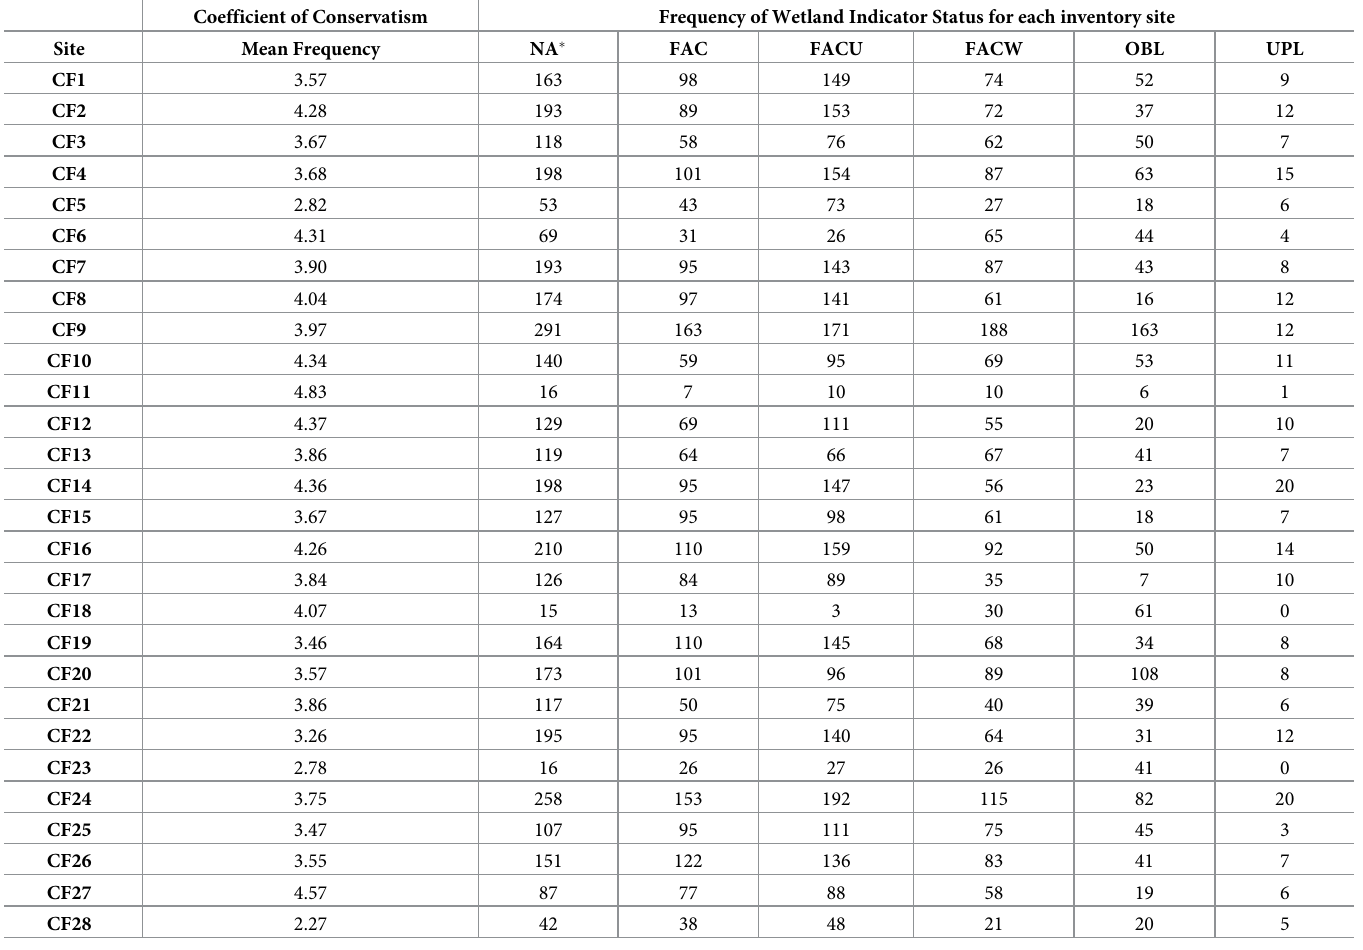
Table 3. Summary of mean frequencies of plant species from each comparison flora assigned to a coefficient of conservatism ranking (values 0 to 10), and frequency of plant species of each flora for wetland indicator status. For coefficients of conservatism a zero (0) value represents an invasive species, a one (1) represents nonnative species, a two (2) is a non-conservative native species that is not specific to a habitat type [often considered weedy], and increasing numbers (to 10) represent species with a narrowing range of ecological tolerances and a decreasing ability to tolerate disturbance. These values follow Zomlefer et al. (2013) [36]. An NA value for wetland indicator status means that no wetland status was applied the species; wetland indicator statuses are facultative (FAC), facultative upland (FACU), facultative wetland (FACW), obli- gate wetland (OBL), and upland (UPL)